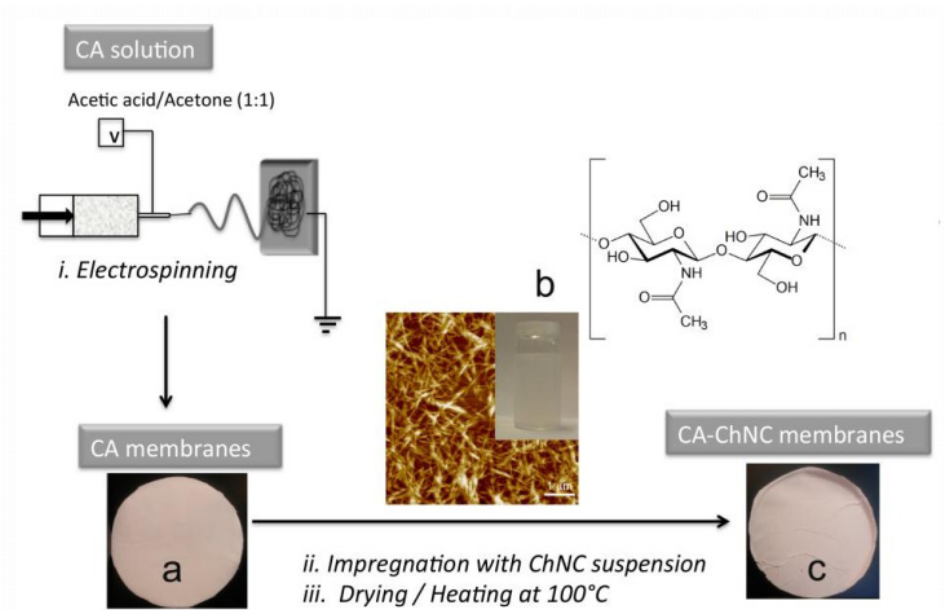
Figure 13. A diagram illustrating the procedures and materials used in the processing and functionalization of membranes. The process phases are as follows: (i) electrospinning of cellulose acetate (CA) mats, (ii) impregnation of CA mats, and (iii) drying and heating of impregnated mats. ( a ) The electrospun CA mat, ( b ) chitin nanocrystals (ChNC) utilized for impregnation (photo of the ChNC suspension, the AFM picture of the nanocrystals, and the chemical structure of chitin), and ( c ) the electrospun CA membrane mat formed after impregnation are exhibited. Reprinted from [188]. Copyright 2016, with permission of